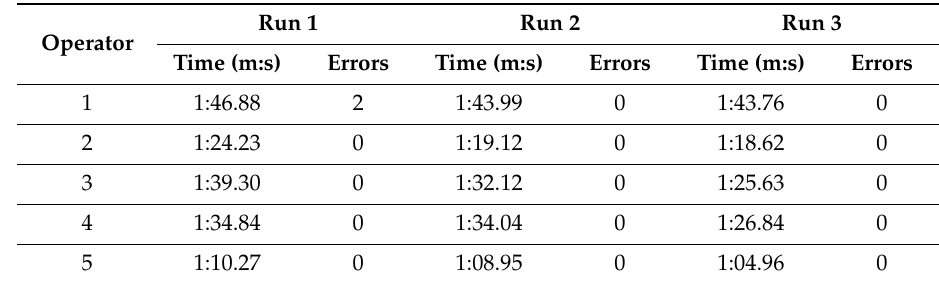
Table 2. Productivity of human subjects transferring 15